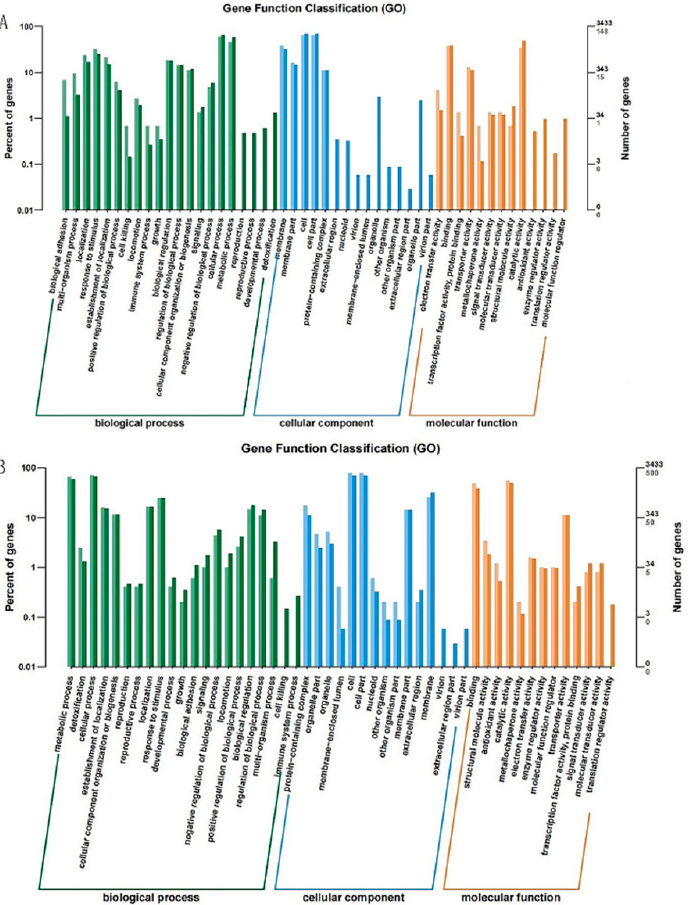
Figure 4. Gene Ontology (GO) enrichment analysis of DEGs. ( A ) Upregulated genes analysis results; ( B ) downregulated genes analysis results.